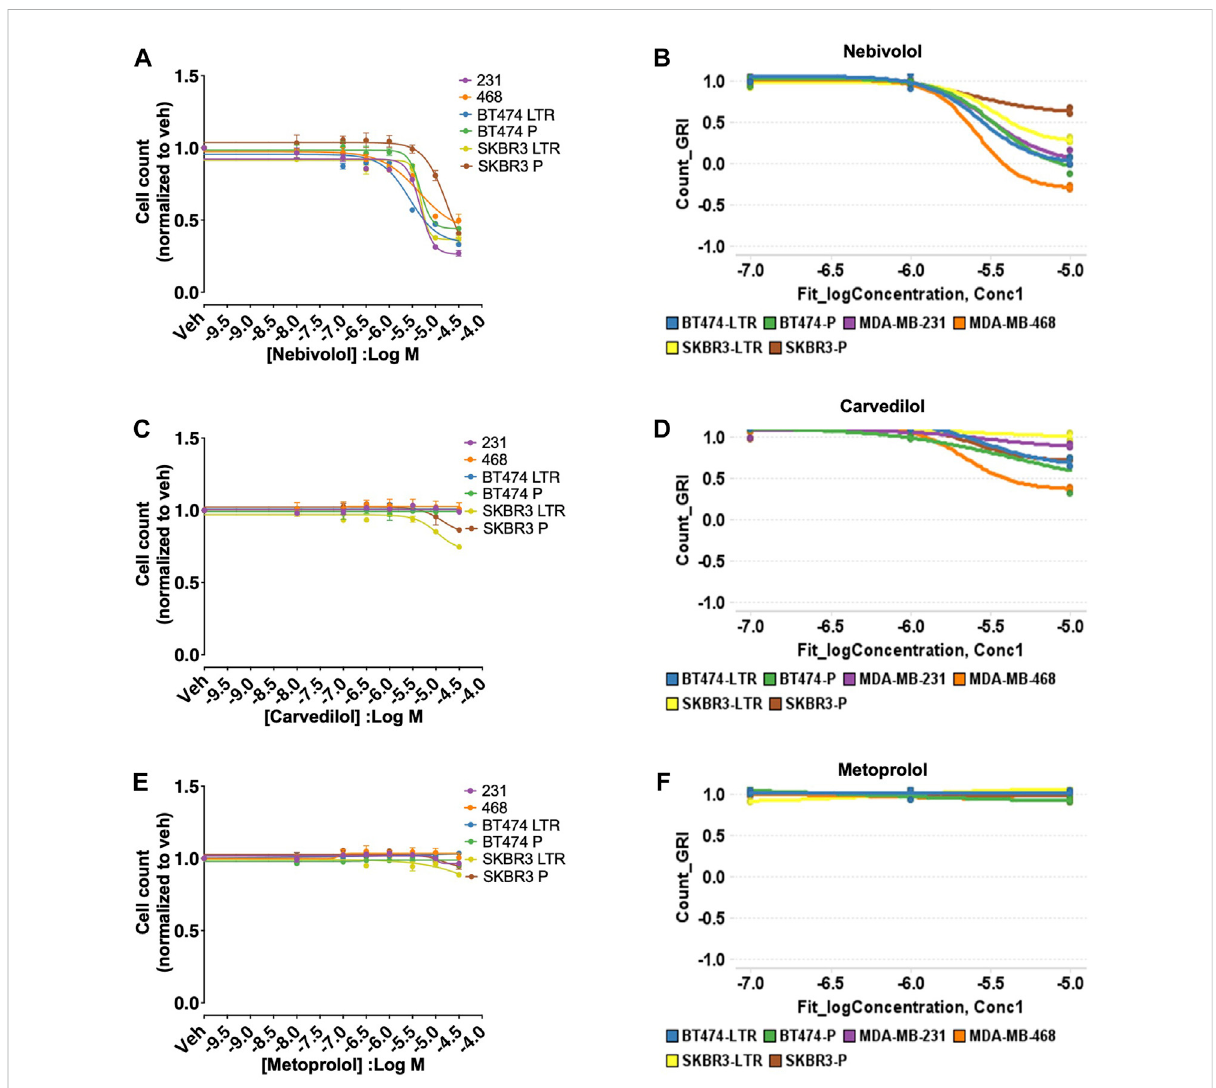
FIGURE 1 HTS and validation studies indicate that nebivolol inhibits cell growth in all six BC cell lines models. (A) Effects of nebivolol on cell growth measured by the cell count in all six BC cell lines models with IC 50 6.57 µM (MDA-MB-231), 4.60 µM (MDA-MB-468), 3.47 µM (BT474 LTR), 7.96 µM (BT474 P), 8.05 µM (SKBR3 LTR), 2.55 µM (SKBR3 P). (B) HTS data for nebivolol with similar effects on cell growth in all six BC cell lines models. (C – F) Carvedilol and metoprolol effects on cell growth measured by the cell count and from HTS data in all six BC cell lines